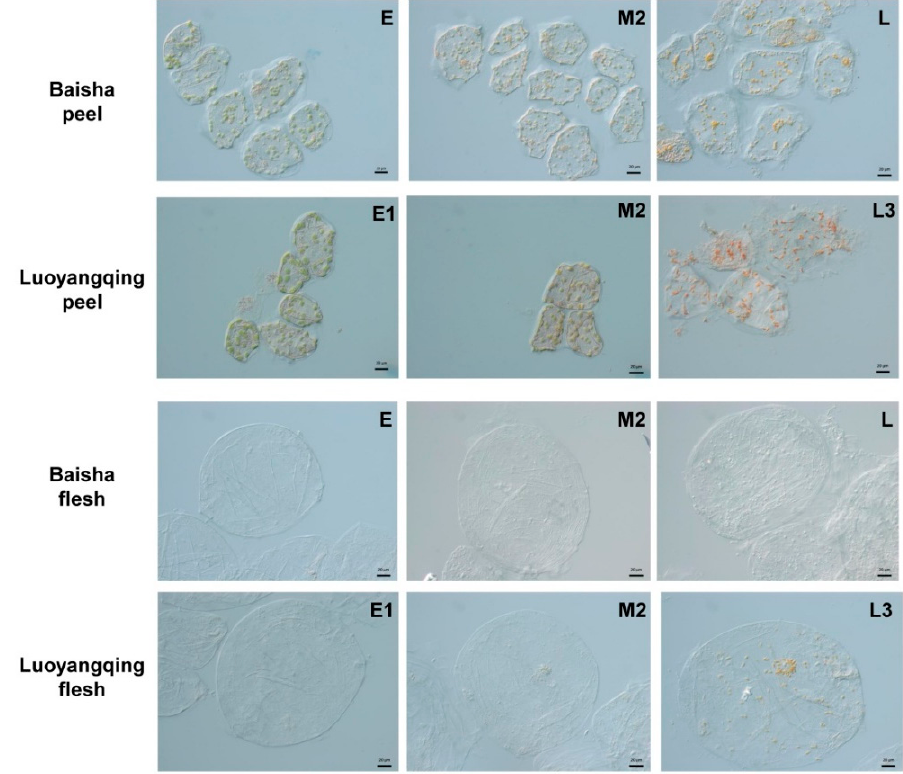
Figure 2. Plastids of Luoyangqing and Baisha loquats in the peel and flesh cells of fruits at early, middle, and late maturity stages under a light microscope. Bar = 20 μ m.